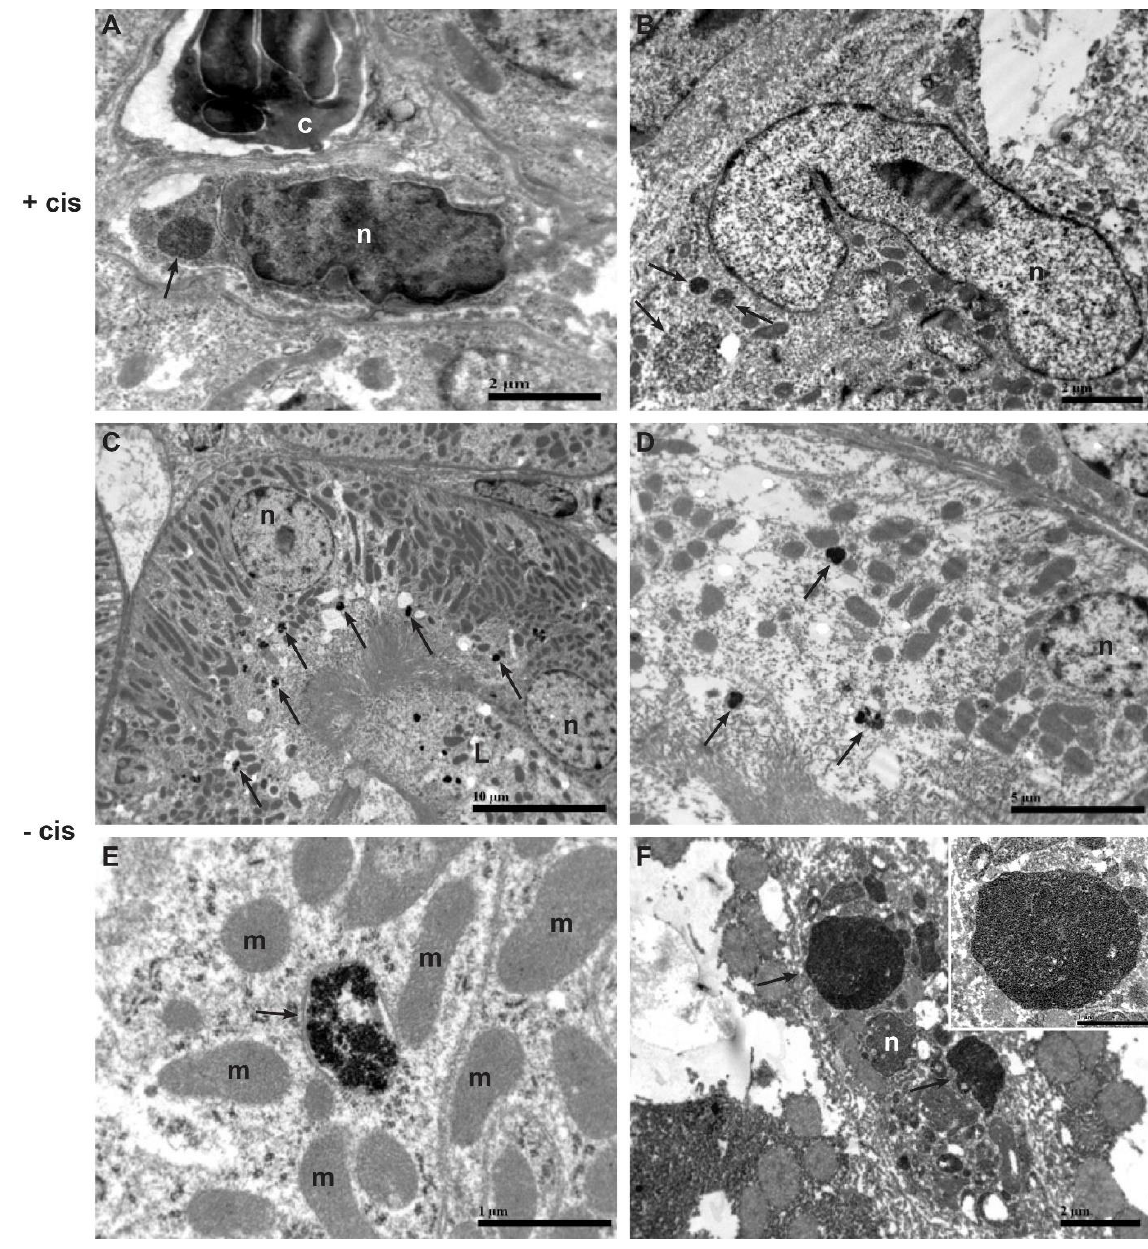
Figure 3. Representative TEM micrographs of intracellular localization of electron − dense NPs in the kidney and intestine of cisplatin-treated mouse (+cis) ( A , B ) and in the kidney and liver of control mouse (−cis) ( C − F ). ( A ) Electron-dense NPs (arrow) in endosome of MSC located in interstitium between peritubular capillary and tubular basement membrane. Scale bar: 2 µm. ( B ) Three endosomes containing electron−dense NPs (arrows) inside the cytoplasm of MSC in intestine. Scale bar: 2 µm. ( C ) Several small endosomes with electron-dense NPs (arrows) in apical cytoplasm of proximal tubular epithelial cells. Scale bar: 10 µm. ( D ) Endosomes with electron-dense NPs (arrows) in basal and apical cytoplasm of proximal tubular epithelial cell. Scale bar: 5 µm. ( E ) Higher magnification of endosome containing NPs (arrow) in proximal tubular epithelial cell. Scale bar: 1 µm. ( F ) Electron-dense NPs in endosomes (arrows) of Kupffer cell. Scale bar: 2 µm. Note a high magnification view of large endosome fully loaded with electron-dense NPs in the upper right corner of the figure. Scale bar: 1 µm. Legend: n−nucleus; c−cytoplasm of neutrophilic granulocyte; L−lumen of proximal tubule; m−mitochondria.